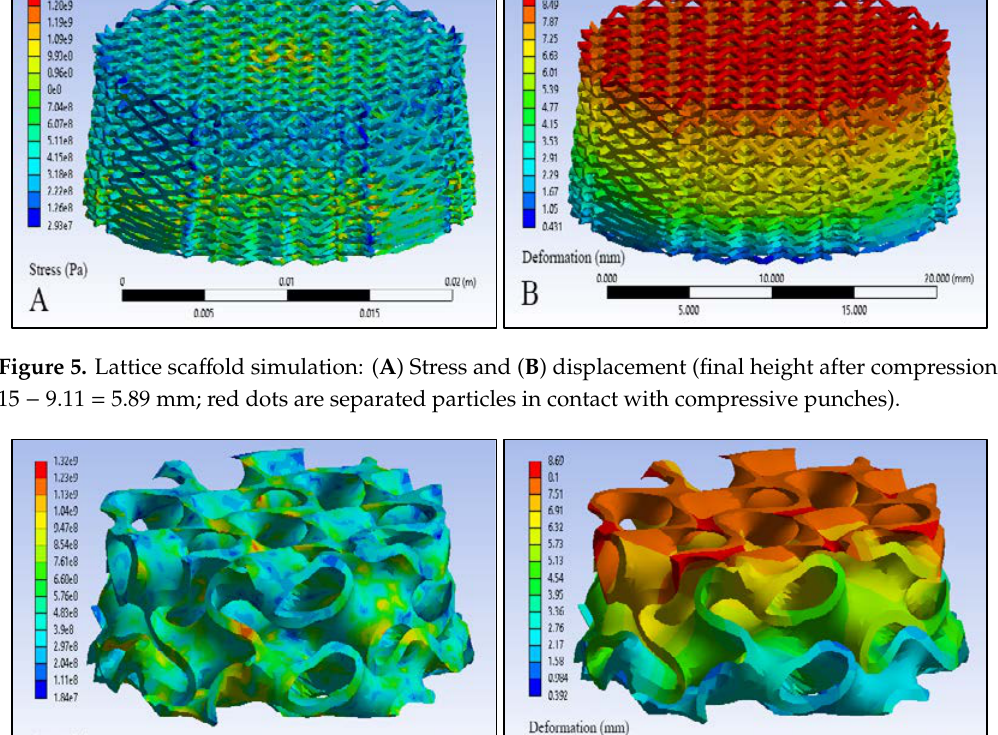
Figure 4. Primitive scaffold simulation: ( A ) Stress and ( B ) displacement (final height after compression 15 − 6.91 = 8.09 mm; the red dots are separated particles in contact with compressive punches).